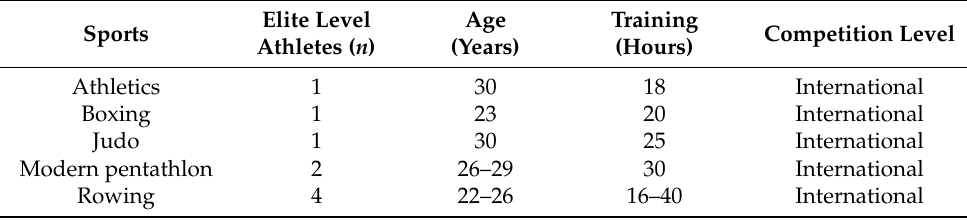
Table 1. Athlete participant characteristics.